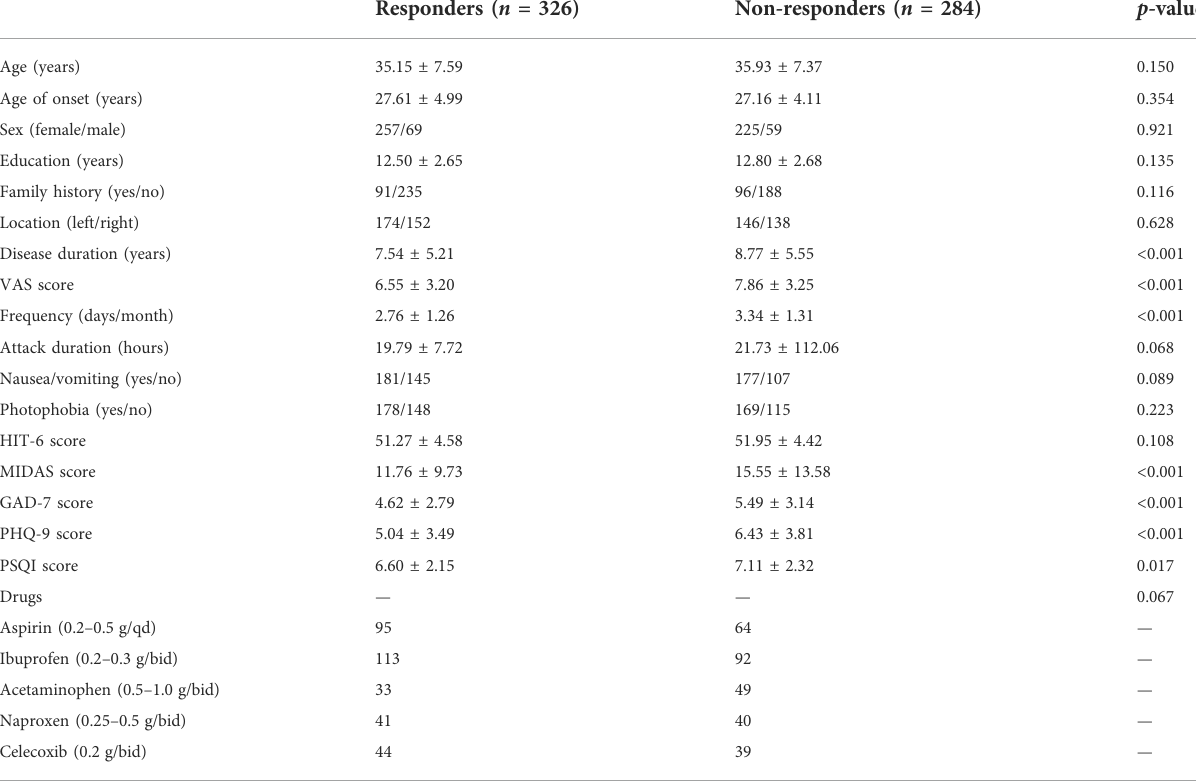
TABLE 1 Baseline demographic, migraine characteristics, and types of medications.